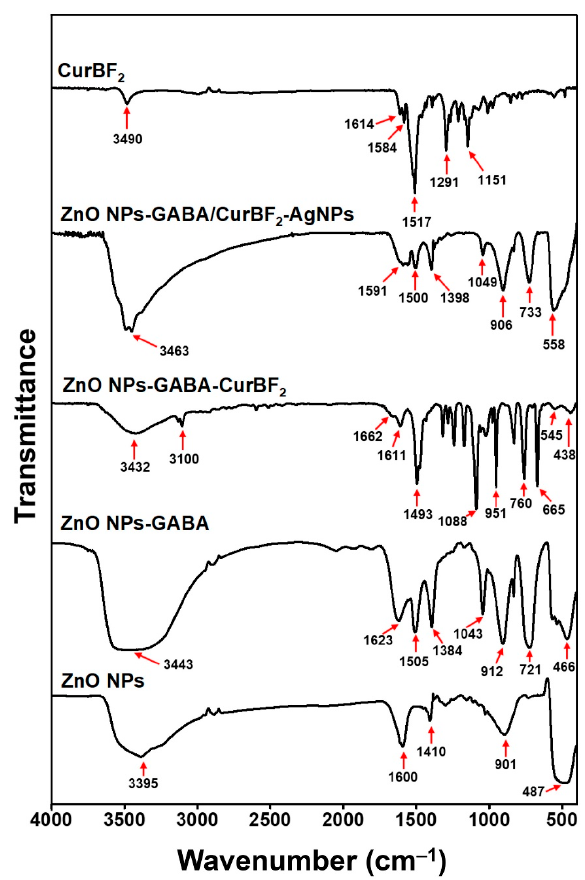
Figure 5. FTIR spectra of CurBF 2 , ZnO NPs-GABA/CurBF 2 -AgNPs, ZnO NPs-GABA-CurBF 2 , ZnO NPs-GABA, and ZnO NPs.